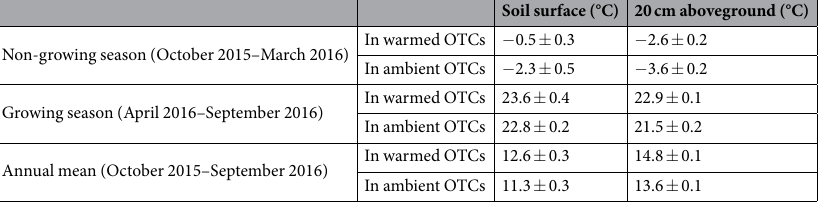
Table 2. Means ( ± SE) of the temperature in warmed and unwarmed open-top chambers